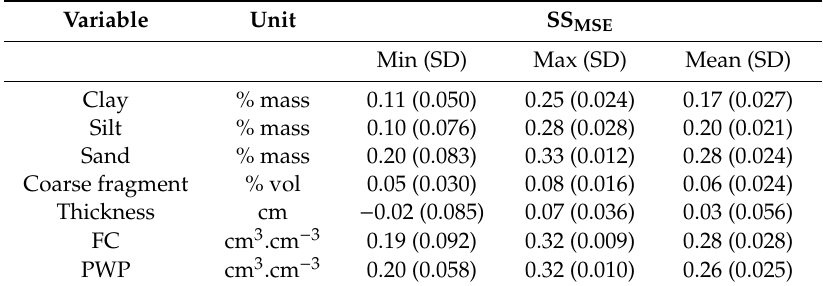
Table 6. Results of mean square error skill score (SS MSE ) for primary and hydraulic properties for di ff erent number of